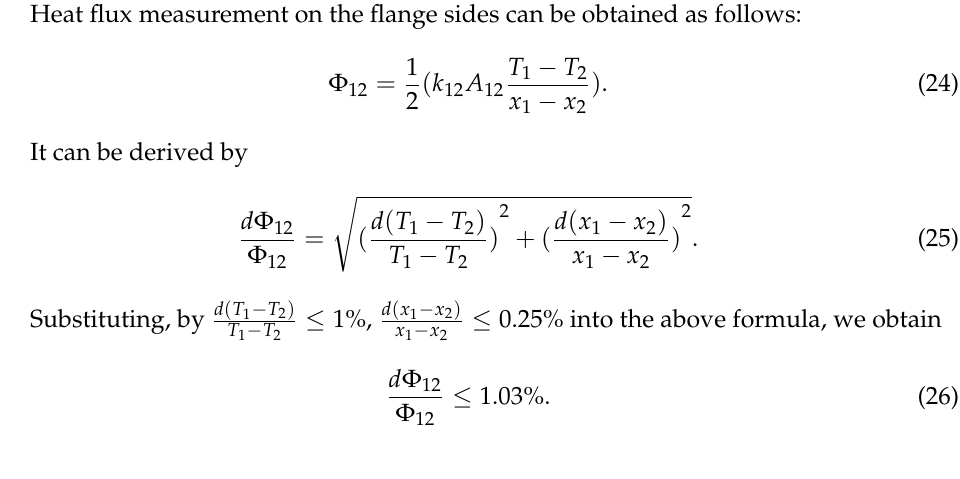
Figure 11. Temperature scanning valve and thin-film platinum resistance.